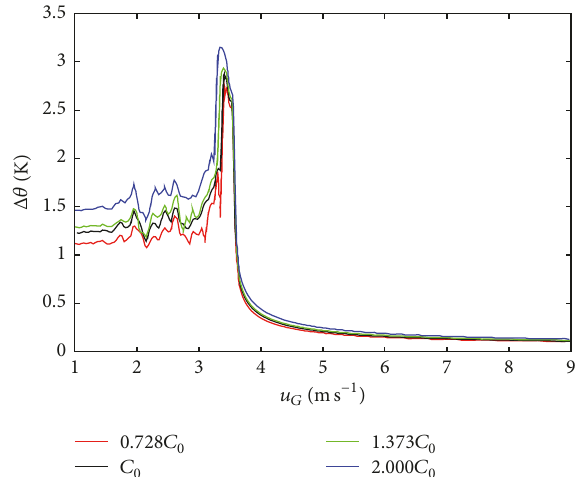
Figure 3: Temperature difference between the scenarios with CO 2 concentrations (indicated by the legend), in relation to the actual carbon dioxide concentration in the disconnected state.